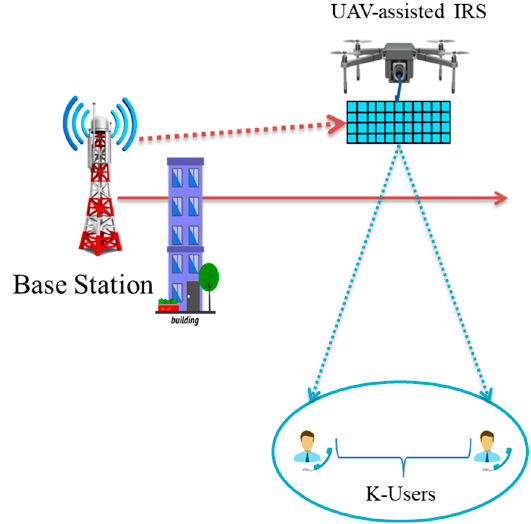
Figure 10. UAV-based IRS-assisted NOMA system. Table 5. Comparison of studies on IRS-assisted NOMA [157].